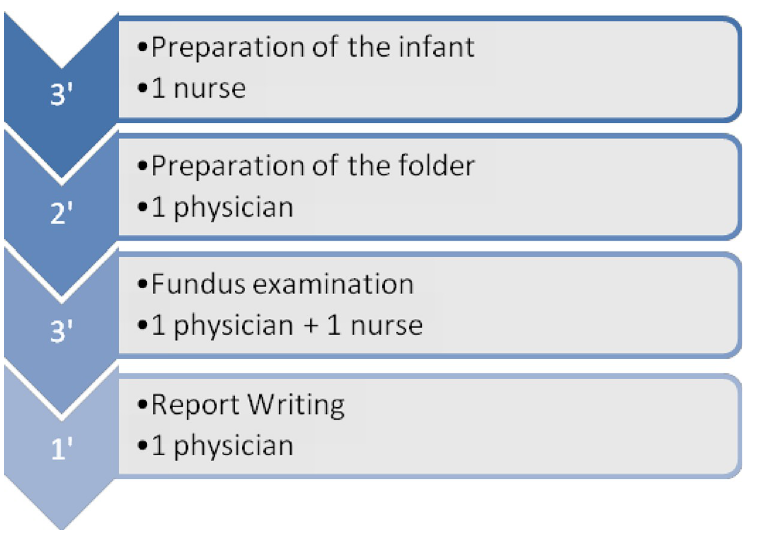
Fig 1. Workflow, standard procedure (minutes).